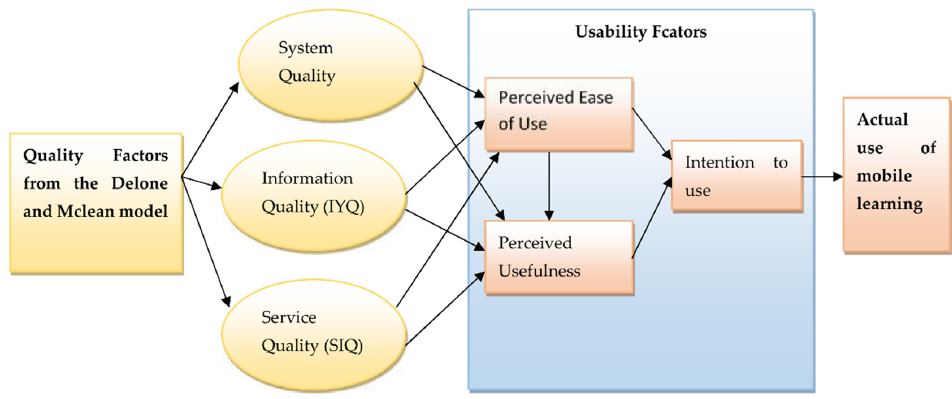
Figure 2. The proposed model.